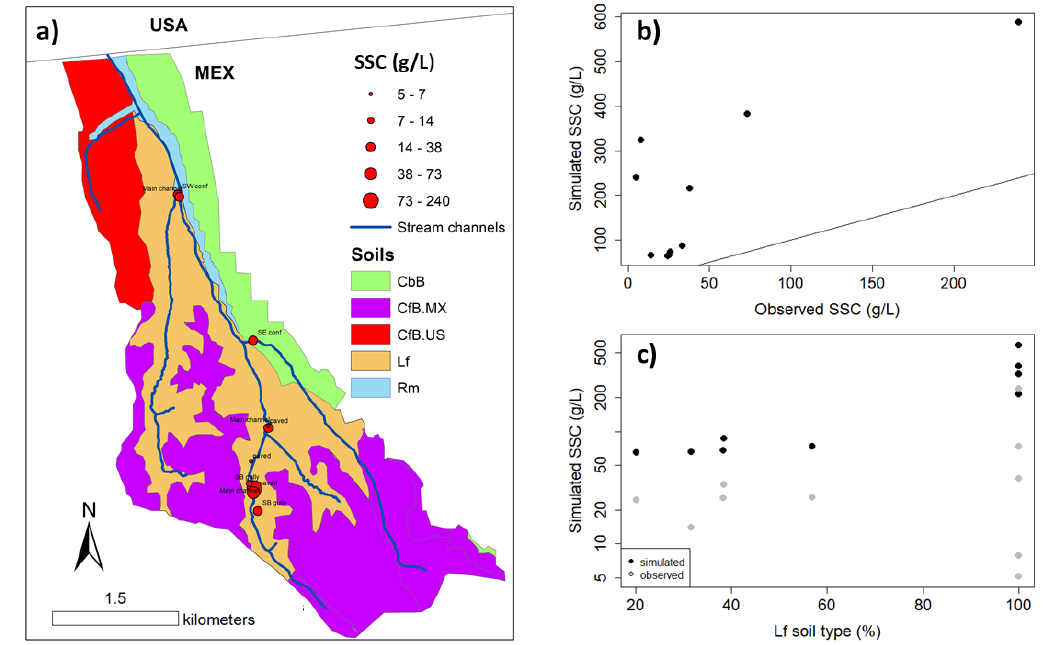
Figure 8. ( a ) Geographic location of storm-water samples, suspended sediment concentration (SSC), and soil types along the LLCW. ( b ) Relationship between observed and simulated SSC (the black line is the 1:1 line) and ( c ) relationship between Las flores (Lf) soil fraction and simulated and observed SSC.